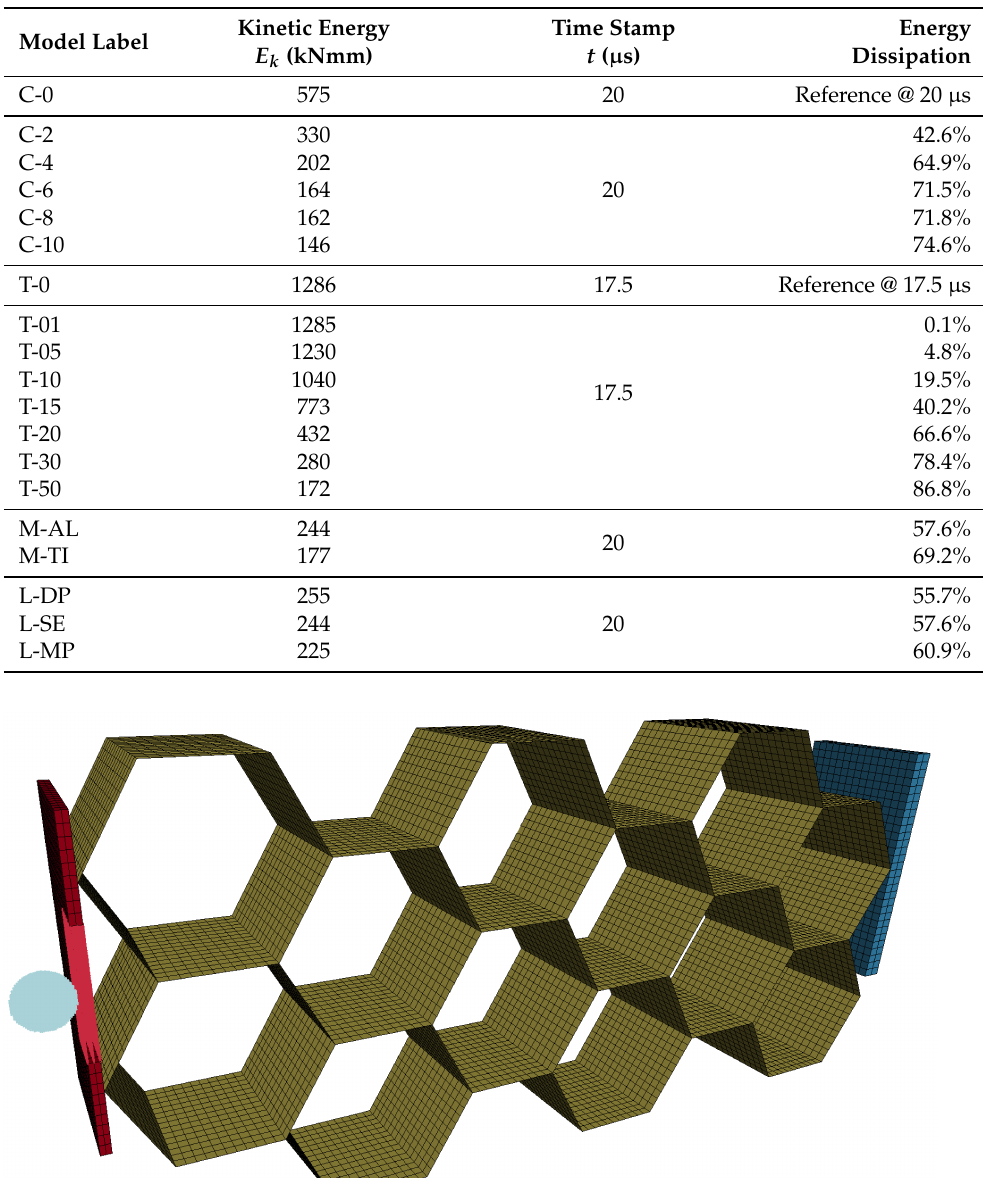
Table 3. Summary of main results and dissipation of kinetic energy for all numerical simulations.